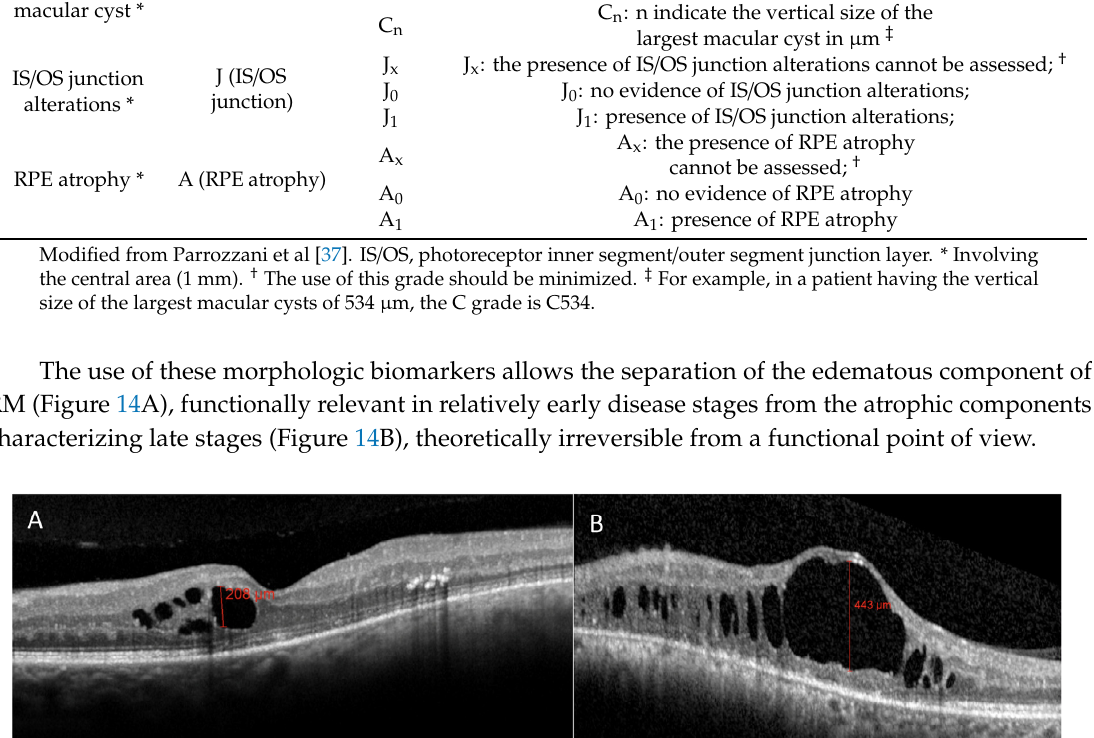
Table 2. Radiation maculopathy features detectable with multimodal imaging . Features